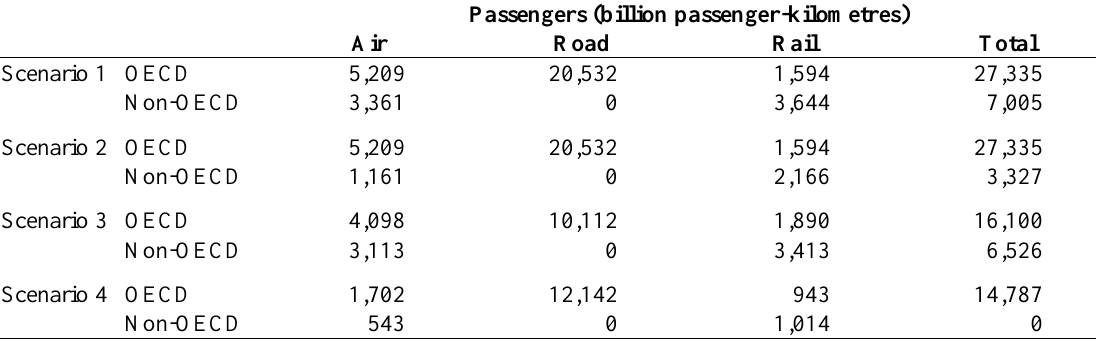
Table 16. Estimated volumes for passenger transport (2020) Passengers (billion